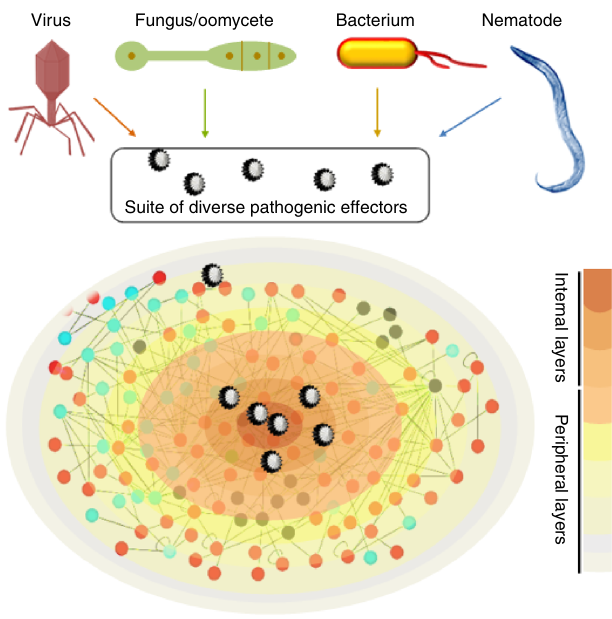
Pathogen effectors target nodes residing in the internal layer of plant interactome Fig. 6 A model illustrating effector targets in plant interactome. Plant protein – protein interaction network (interactome) exhibiting direct physical interactions is demonstrated in the internal and the peripheral layers. Viral, fungal/oomycete, bacterial, and nematode pathogens delivering suite of pathogenic effectors are shown. A key to the color scheme representing the internal and the peripheral layers is